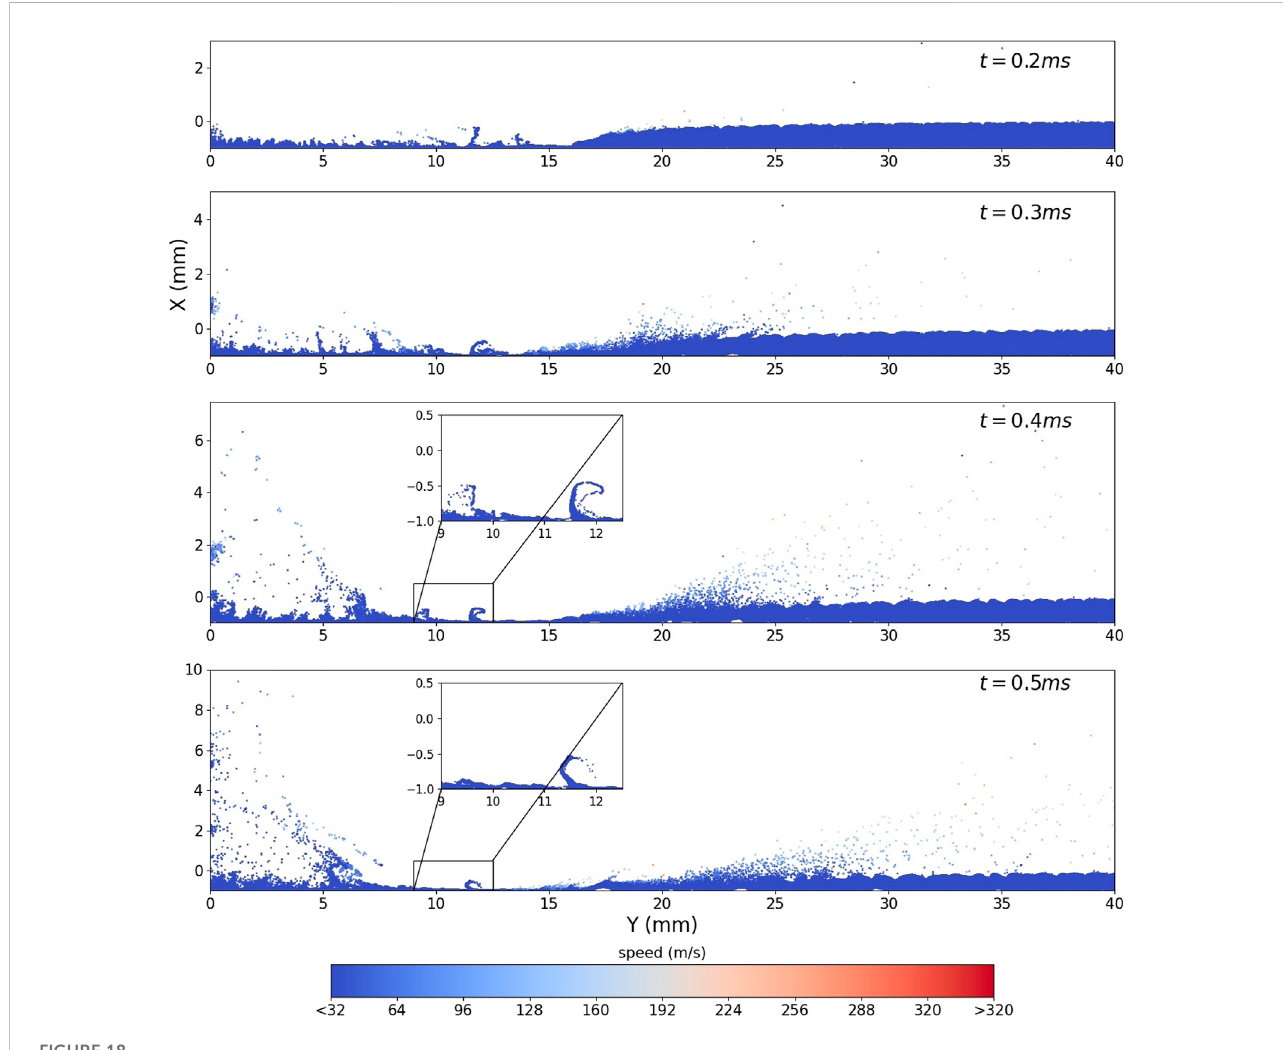
FIGURE 18 Regolith layer evolution with the MPPIC method: dispersion.